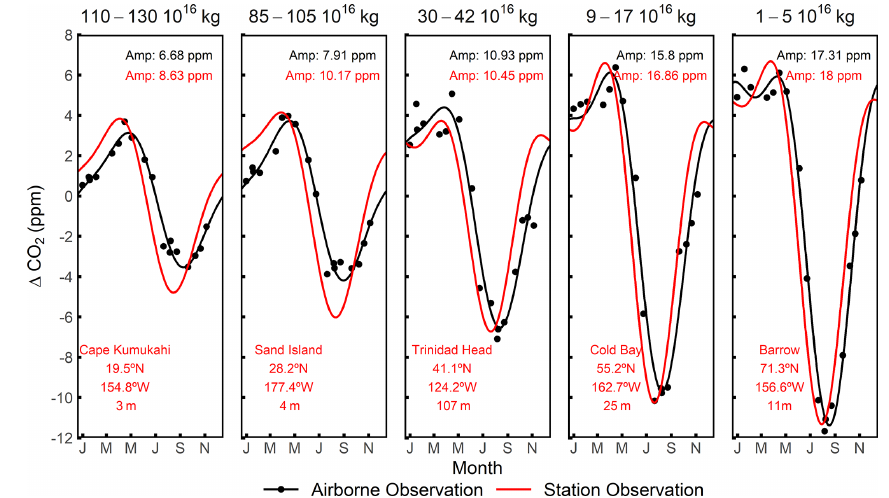
Figure 10. CO 2 seasonal cycles of multiple surface stations (2009–2018) compared to seasonal cycles of airborne observations averaged over corresponding M θ bin. The choice of M θ bin is to approximate the range of M θ at each corresponding surface station and is shown e e e of the station is computed from ERA-Interim, based on its location. We detrend station and airborne at the top of each panel. Daily M θ e observations by subtracting the MLO stiff cubic spline trend. We compute average detrended CO 2 for each airborne campaign transect and bin, shown as black points. The seasonal cycles are computed from a two-harmonic fit, with the seasonal amplitude (Amp) shown each M θ e in the upper right of each panel.